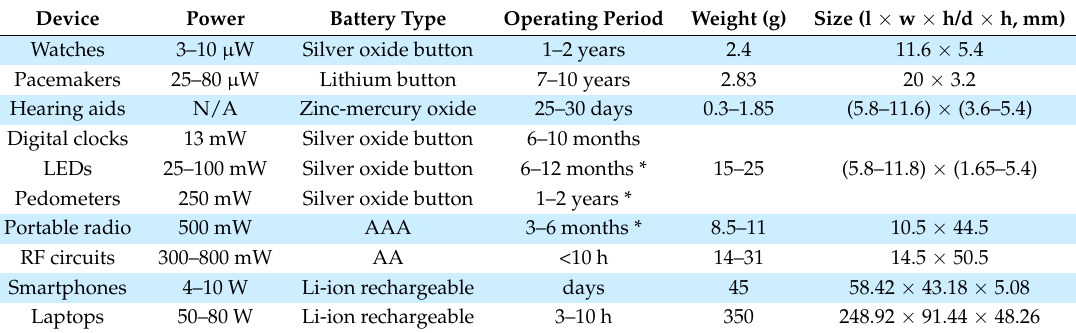
Table 3. Examples of wearable devices and the basic characteristics of their batteries. (*) The operating period depends on the usage